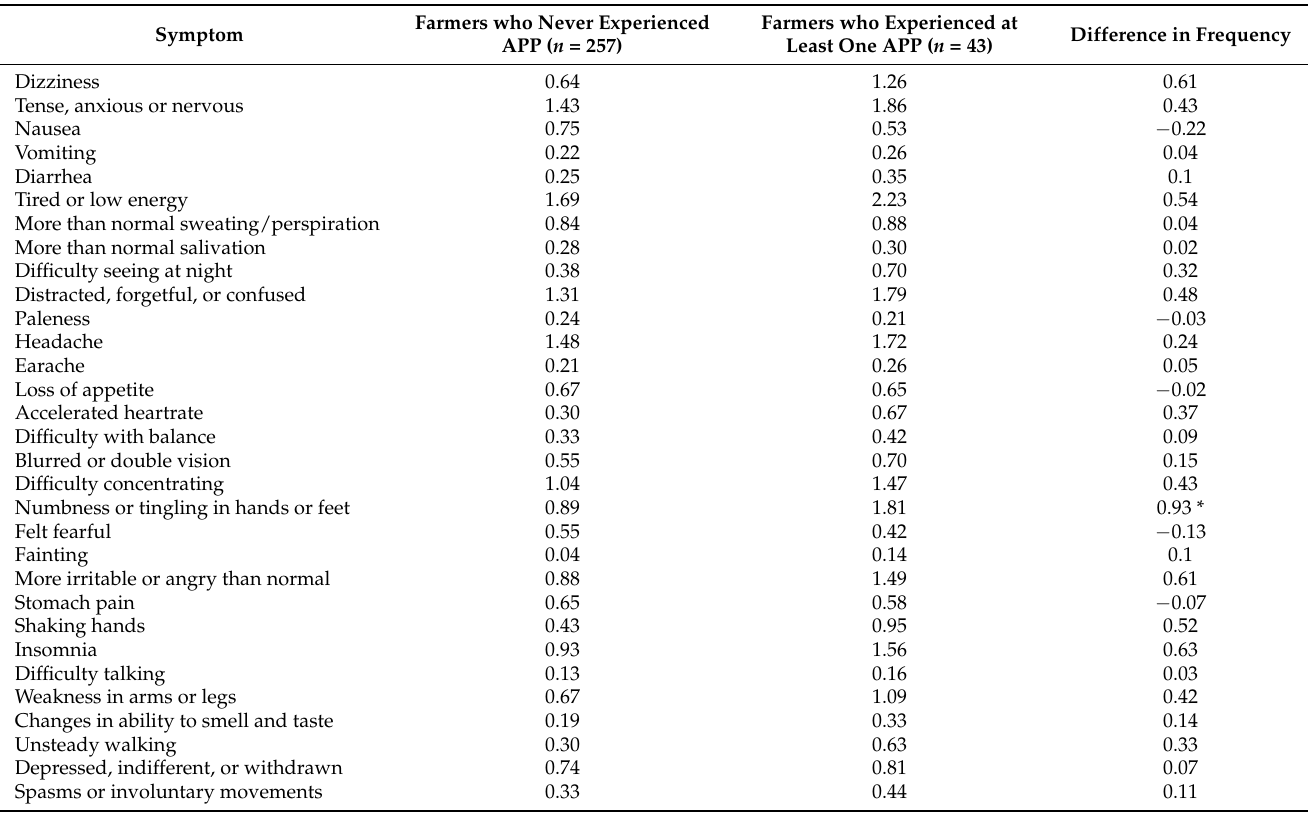
Table 1. Mean frequency of symptoms during the 12 months prior to interview reported by Figure 1, from 0 (never) to 4 (more than once a week). Farmers who Never Experienced Farmers who Experienced at Symptom APP ( n = 257) Least One APP ( n =